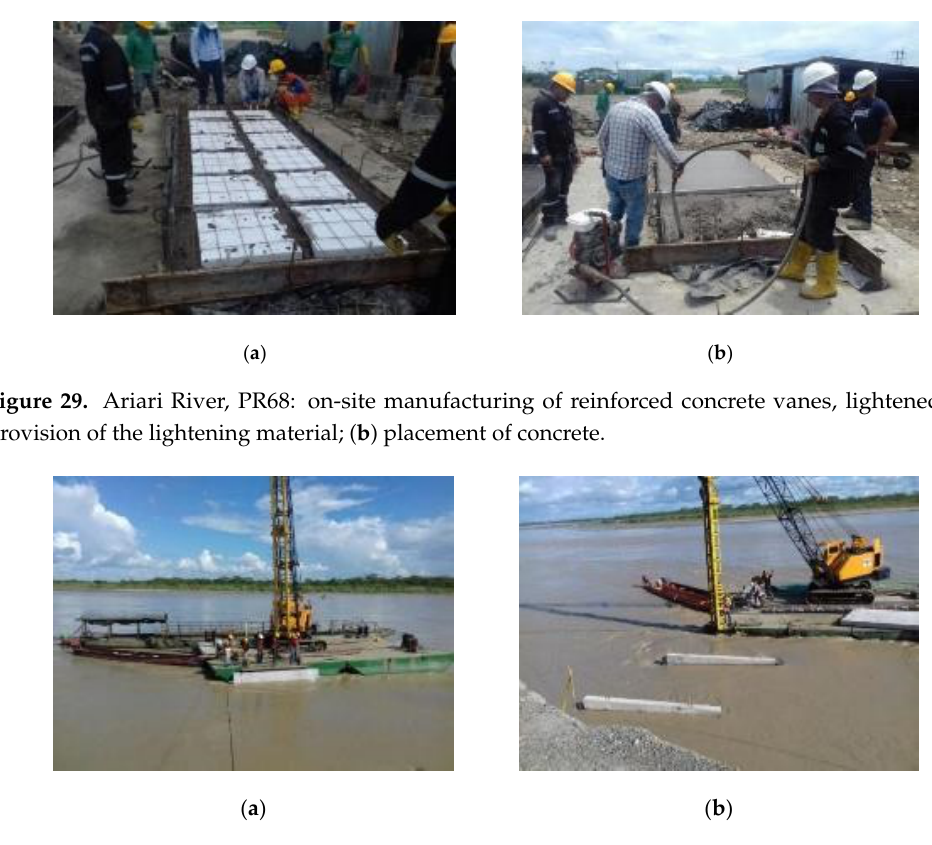
Figure 30. Ariari River, PR68: installation of vanes. ( a ) Positioning according to the design; ( b ) array in the process of installation.